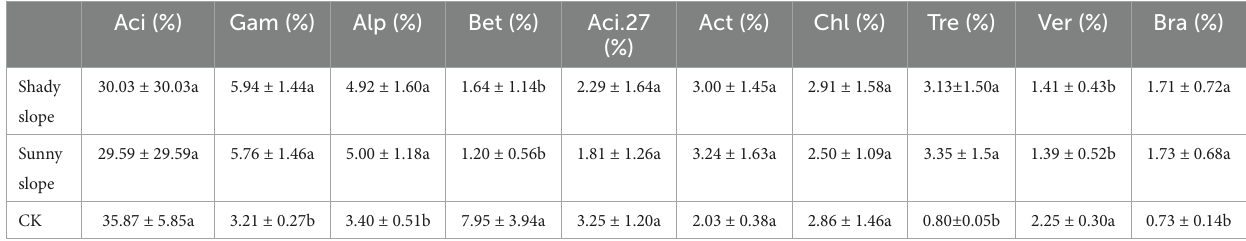
TABLE 3 The variation in relative abundance of the most abundant (top ten) microbial species in samples along the slope direction.